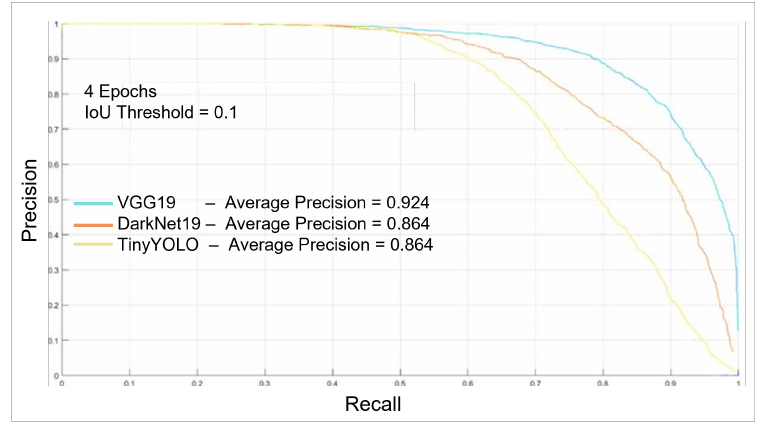
Figure 27. Recall–precision curve for VGG19, DarkNet, and TinyYOLO networks trained for 4 epochs. IoU threshold = 0.1.